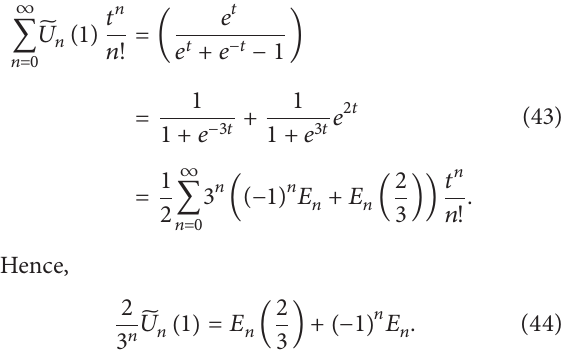
Figure 3: Stacks of zeros of